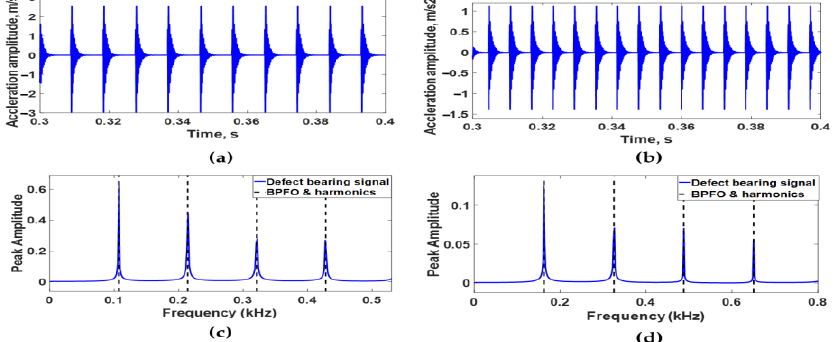
Figure 17. ( a ) Simulated acceleration signal of single defect on outer race, ( b ) simulated acceleration signals of single defect on inner race, ( c ) envelope spectrum of simulation results of single defect on outer race, and ( d ) envelope spectrum of simulation results of single defect on inner race.